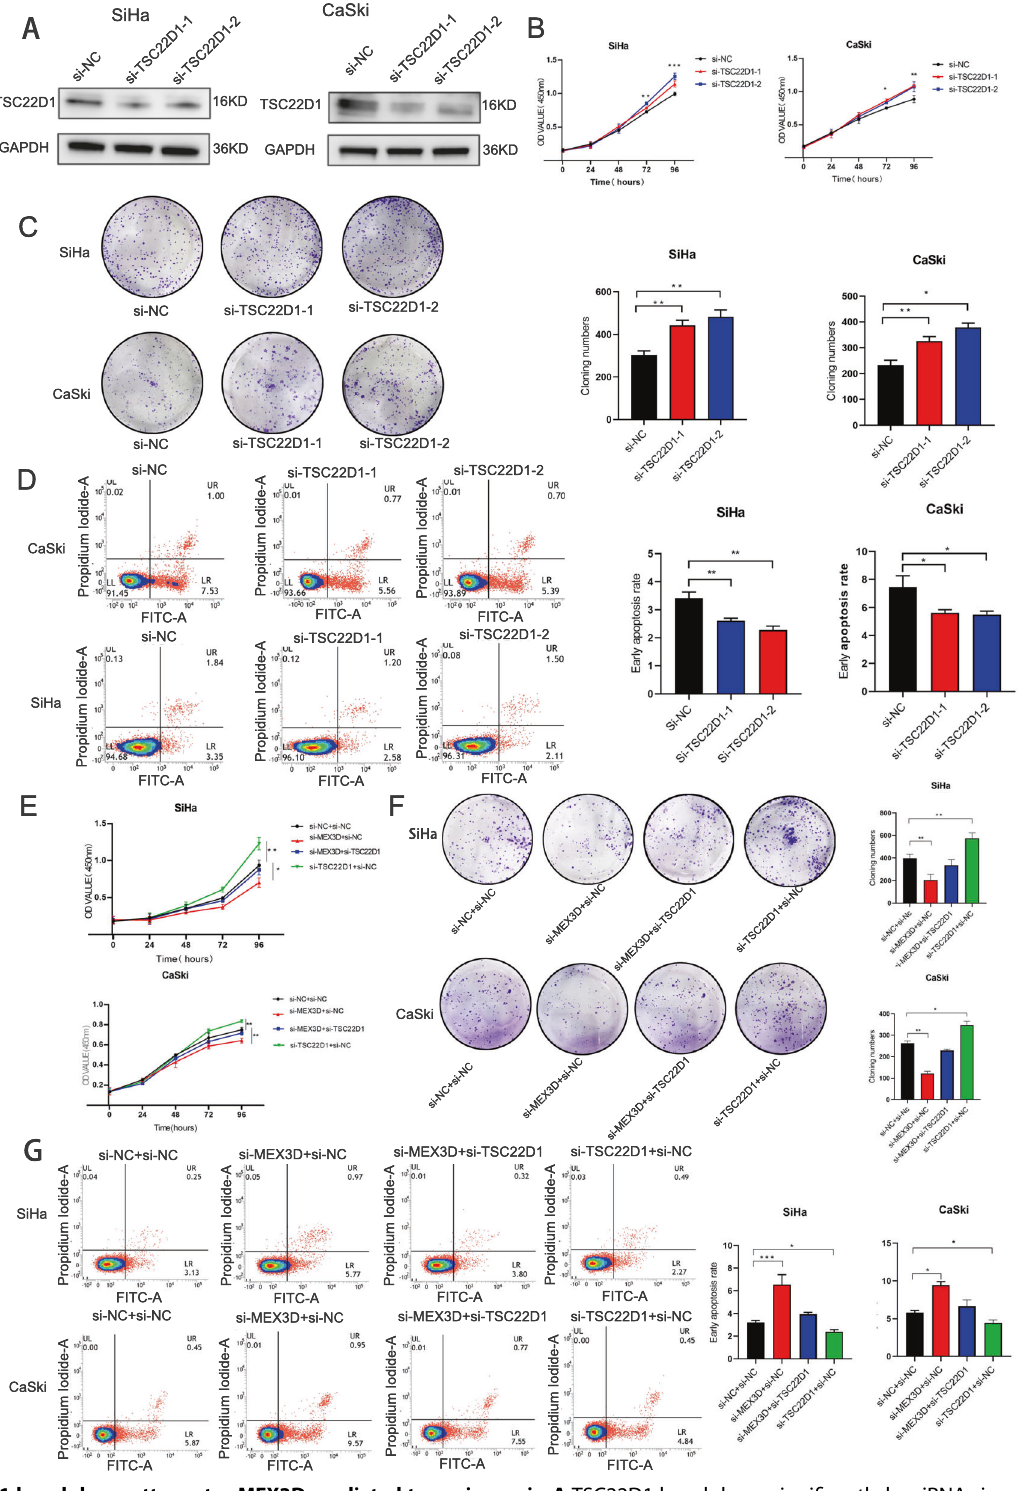
Fig. 4 TSC22D1 knockdown attenuates MEX3D-mediated tumorigenesis. A TSC22D1 knockdown signi fi cantly by siRNAs in protein levels in CaSki and SiHa cells. B – D TSC22D1 knockdown stimulated cellular proliferation, whereas the suppressed rate of cellular apoptosis. E – G TSC22D1 knockdown mitigated the decreased cell proliferation and increased cellular apoptotic rate mediated by MEX3D knockdown. * P < 0.05, ** P < 0.01, and *** P < 0.001.